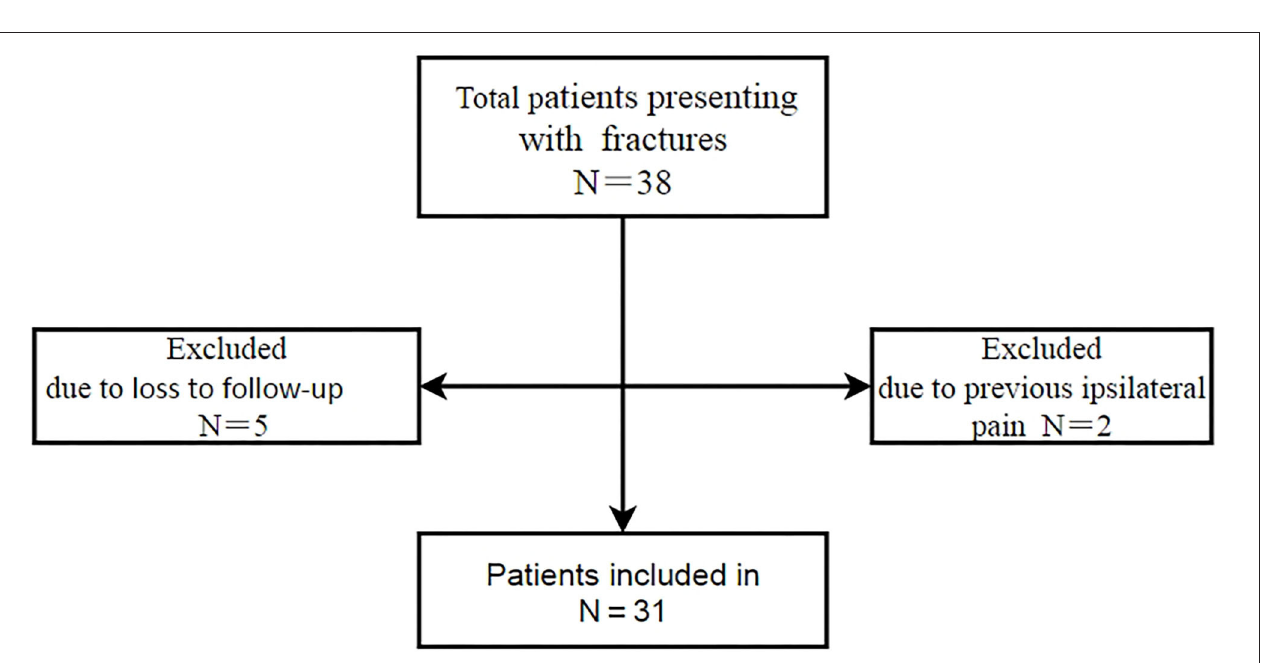
(3). Non-operative therapy was the gold standard for a medial clavicle fracture even when fractures were displaced. However, Throckmorton et al. reported 28% moderate to severe pain in